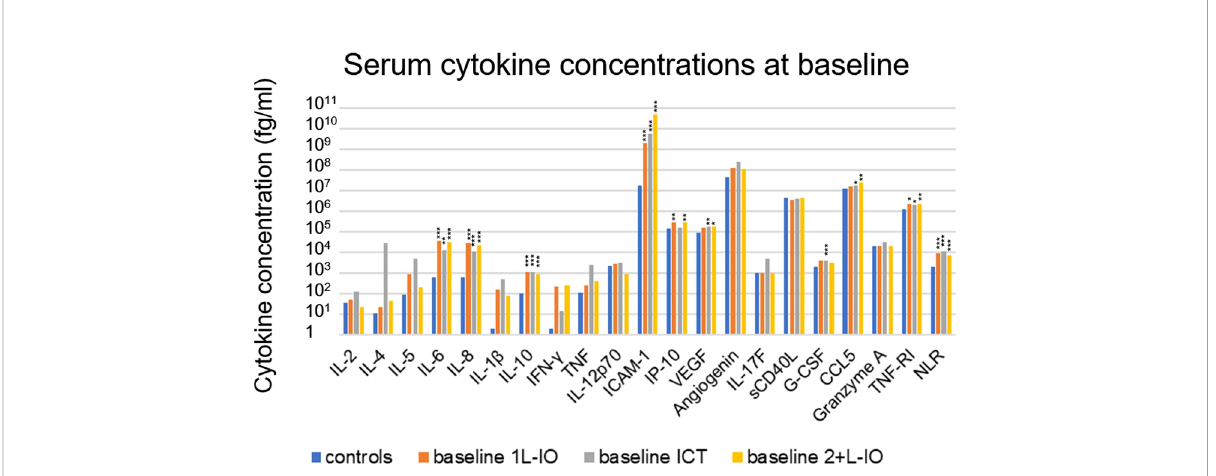
FIGURE 2 Cytokine levels before immunotherapy start in newly diagnosed and chemotherapy-pretreated NSCLC compared to age-matched healthy control donors. Shown is the mean concentration of each cytokine in fi rst-line patients at baseline, as well as in age-matched healthy controls. An overview of signi fi cant results and the explanation of abbreviations is shown in Table 2. In newly diagnosed patients IL-6 (FC=31, p=0.0002), IL-8 (FC=25, p=4x10 -8 ), IL-10 (FC=11, p=0.0002), CCL5 (FC=1.4, p=0.026), G-CSF (FC=5, p=0.004), ICAM-1 (FC=261, p=9x10 -7 ), TNF-RI (FC=1.6, p=0.021), VEGF (FC=2, p=0.007) and NLR (FC=5, p=10 -9 ) were elevated. In pretreated patients IL-6 (FC=49, p=5x10 -6 ), IL-8 (FC=34,